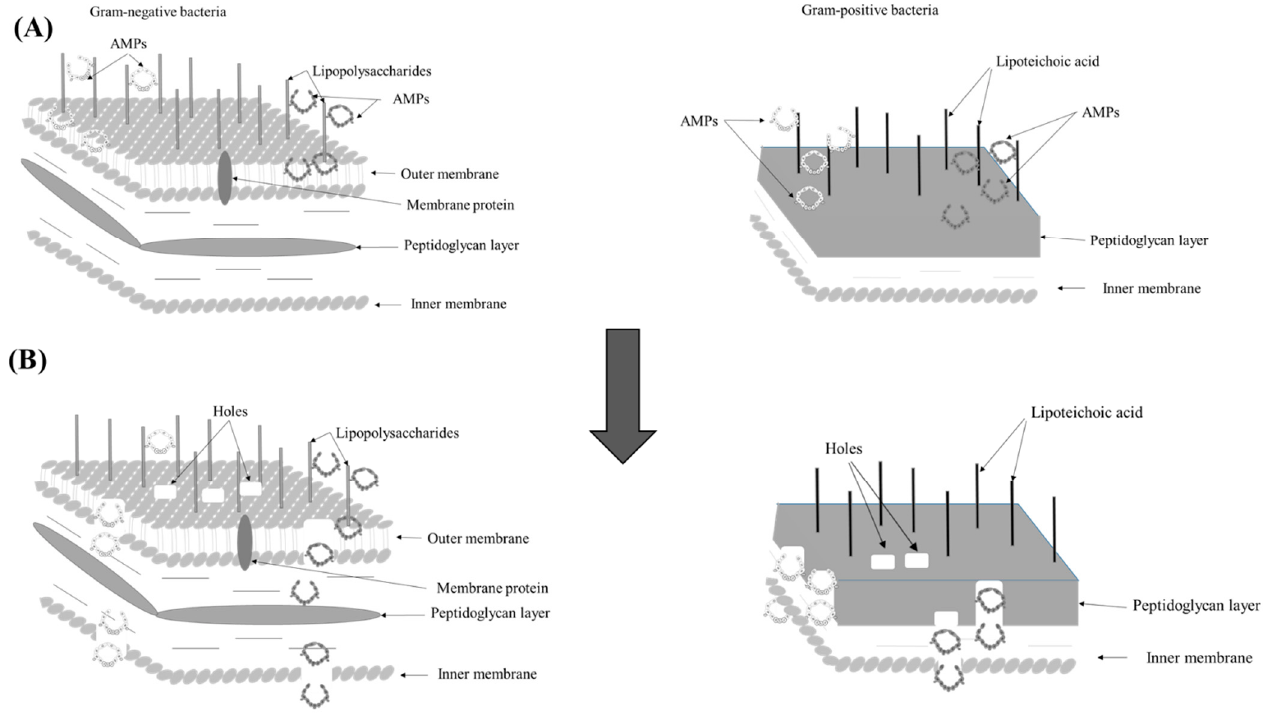
Figure 1. The suggested mechanism of action of the novel AMPs. ( A ) The electrostatic interactions between the peptides and negatively-charged bacterial cell walls. ( B ) The penetration of the peptides into the bacterial cell walls, leaving holes behind.